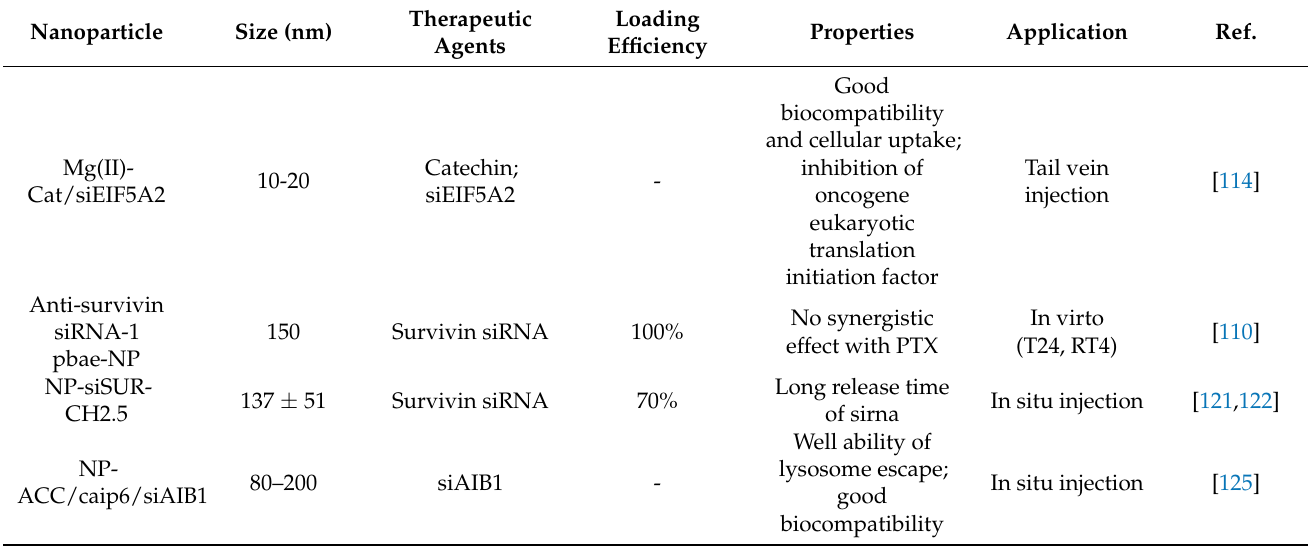
Table 6. Nano-formulations for targeted